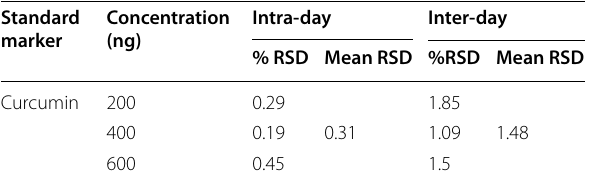
Table 2 Intra -day and Inter-day precision